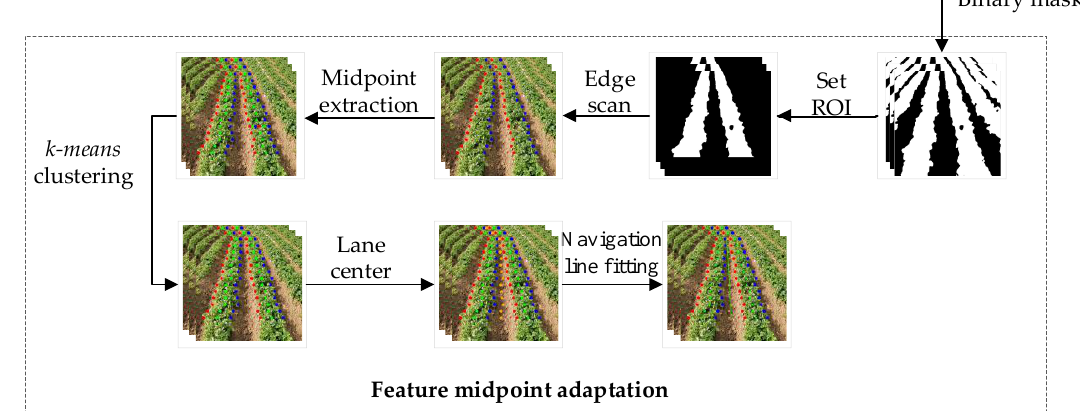
Figure 1. The flow of the visual navigation line detection method.